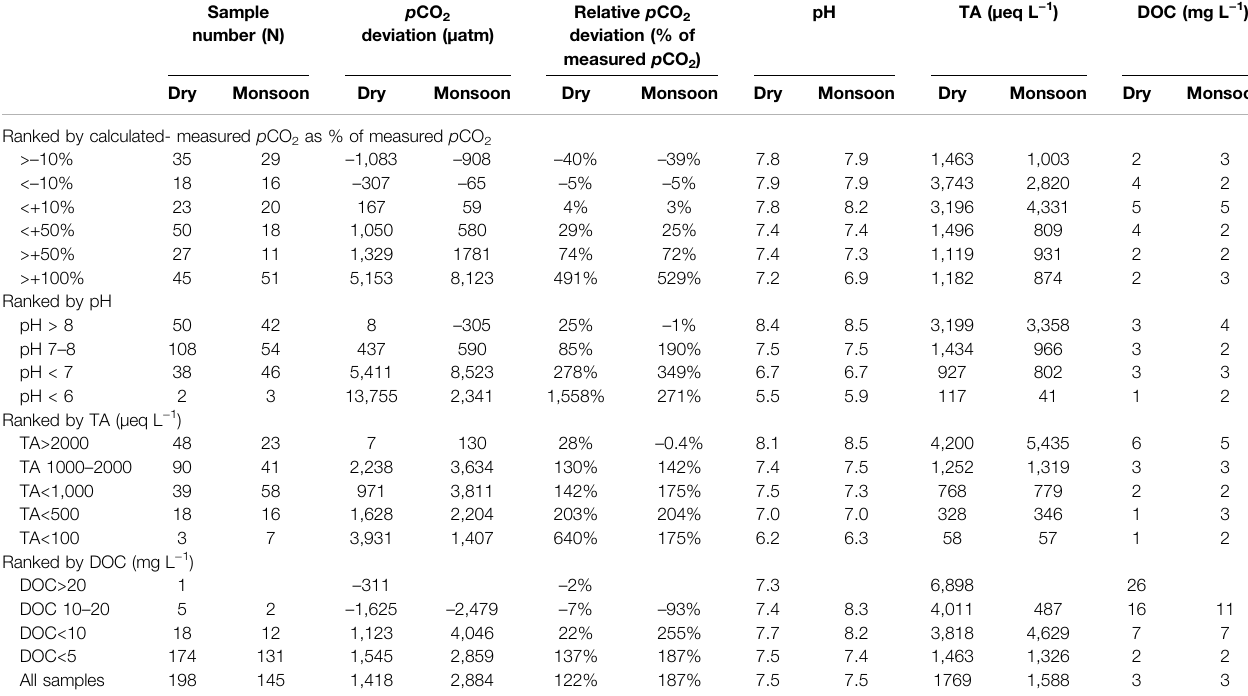
TABLE 3| SeasonalvariationsinthemeanpartialpressureofCO 2 ( p CO 2 )deviations(calculated minusmeasured valuesand theirproportions inmeasured values), pH,total alkalinity (TA), and dissolved organic carbon (DOC) in the fi ve Asian Rivers during the dry and monsoon (wet)